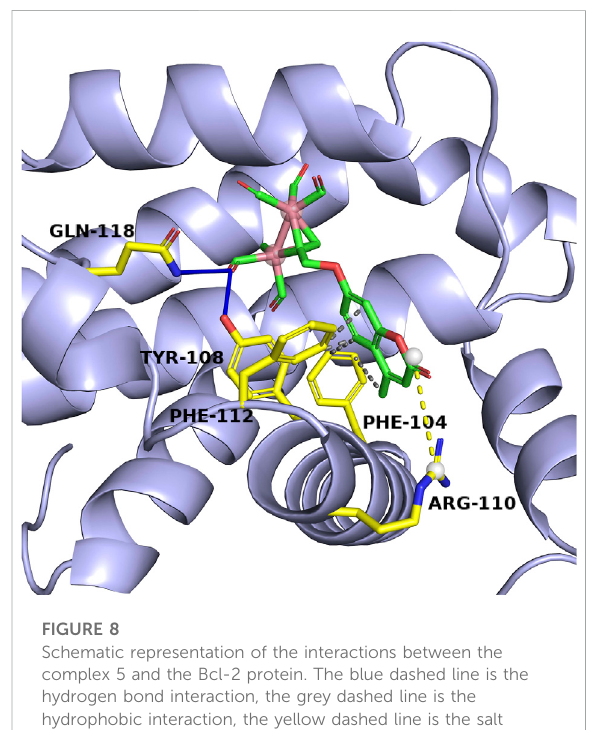
FIGURE 8 Schematic representation of the interactions between the complex 5 and the Bcl-2 protein. The blue dashed line is the hydrogen bond interaction, the grey dashed line is the hydrophobic interaction, the yellow dashed line is the salt bridge, the yellow sticks model is the amino acid residue and the green sticks model is the target small molecule.